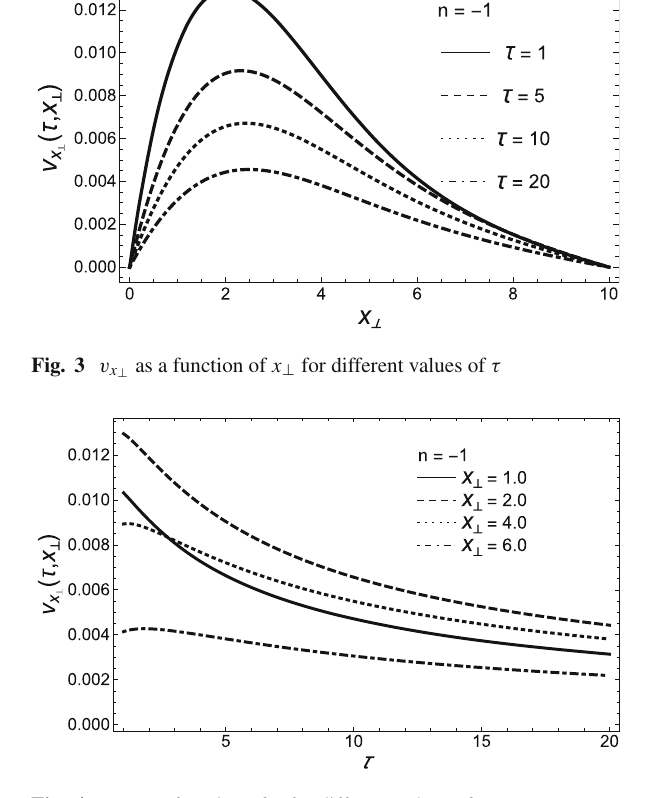
≡ u ⊥ / u τ ) Next we show plots of the fluid velocity ( v x ⊥ and of the energy density modified by the magnetic field /(cid:5) = 0 . 1. In Figs.3 and 4 v (τ, x ⊥ ) is displayed, with B 2 c x ⊥ c at either fixed τ or fixed x ⊥ , respectively. From Fig.3, one (τ, 0 ) = 0 and the radial velocity v finds that v x x ⊥ first ⊥ increases from x ⊥ = 0, has a maximum at intermediate x ⊥ and then gradually decreases with x ⊥ . As shown in Fig.4, v x ⊥ at fixed x ⊥ becomes smaller at late times, due to the decay of the magnetic field, in agreement with the curves displayed in Fig.3.